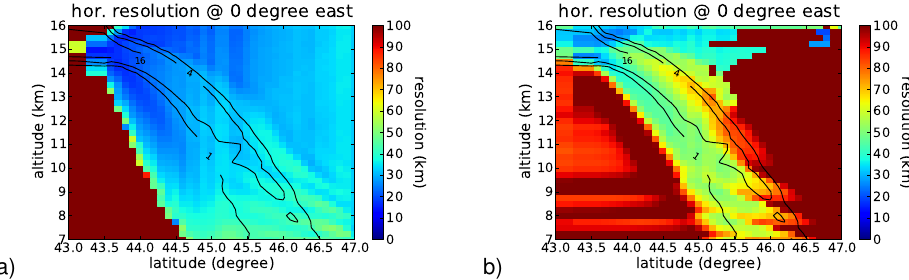
Fig. 5. The horizontal resolution for a linear flight track. Panel (a) gives the horizontal resolution in along track direction (zonal), while panel (b) gives the horizontal resolution in across track direction (meridional). The number of tangent points within the depicted volume elements is overlaid as a contour plot.